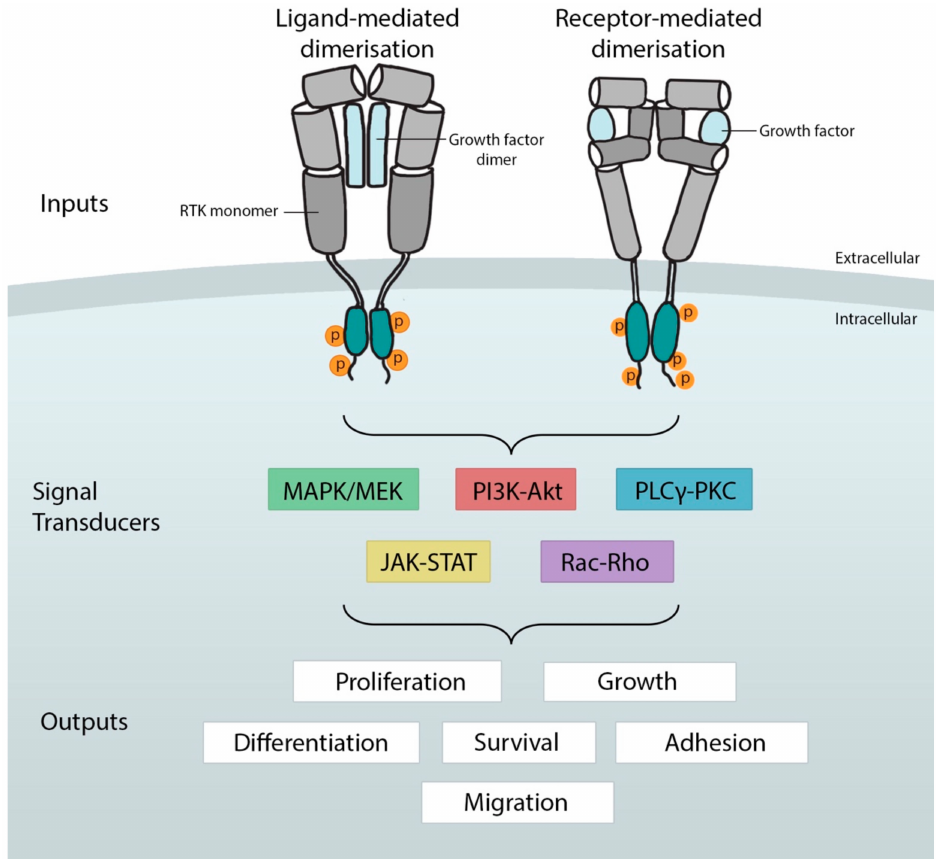
Figure 1. General overview of receptor tyrosine kinase activation, signaling, and the cell-fate decisions they influence. The binding of growth factors (inputs) in the extracellular milieu induces conformation changes in the receptor monomer that enables dimerization. Enzymatic autophosphorylation (circled p) by intracellular tyrosine kinase domains in trans results in recruitment of one or more signal transduction cascades. These relay the signal to e ff ectors that determine cell fates (outputs). Mitogen-activated protein kinase, MAPK; phosphatidylinositol 3-kinase–protein kinase B, PI3K–Akt; phospholipase C gamma–protein kinase C, PLCgamma–PKC; Janus kinase and signal transducer and activator of transcription,